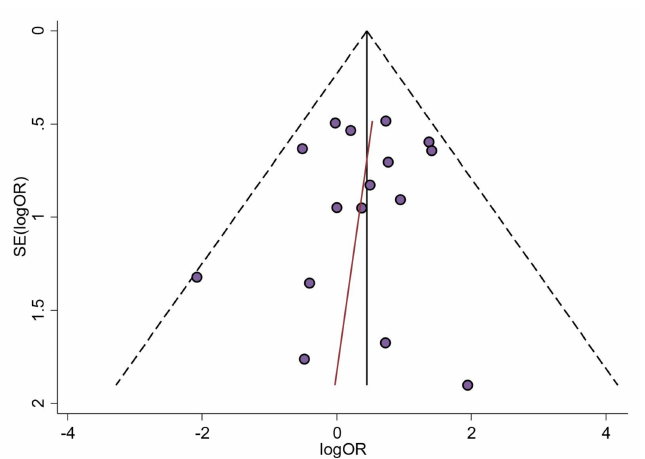
Figure 4. A funnel plot of estimated logOR against its standard error, graphically representing the analysis of “small-study” effects on Breslow thickness. The black vertical line corresponds to the pooled estimated prevalence. The two diagonal intermittent lines represent the pseudo-95% confidence interval. The purple circles represent the published studies. The blue line represents the fitted line corresponding to Egger’s regression test ( p Egger = 0.56) for funnel-plot asymmetry. SE, standard error; OR, odds